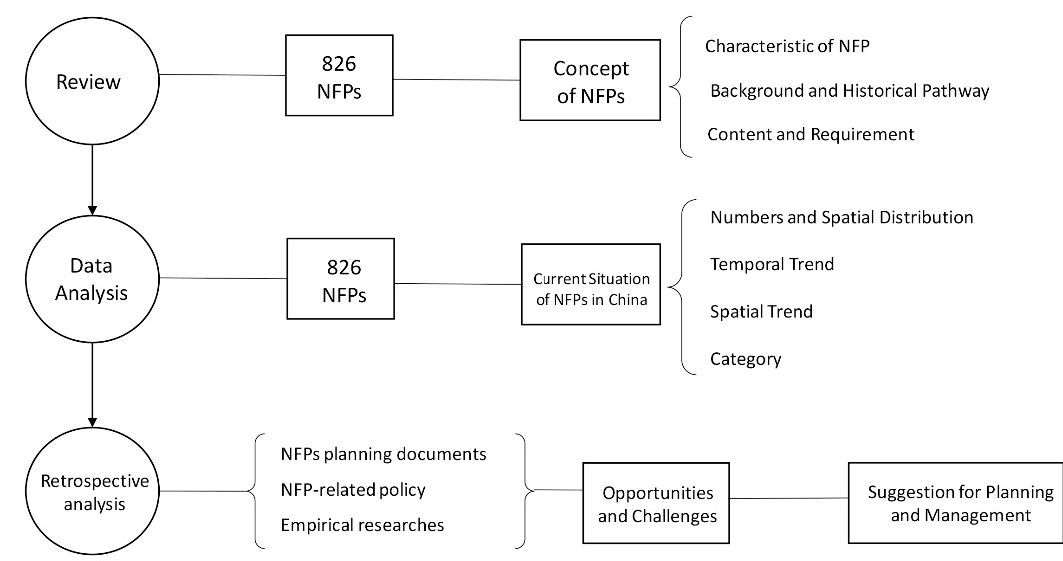
Figure 1. Framework for the study of National Forest Parks (NFPs) in China (Designed and Drawn by the first author).